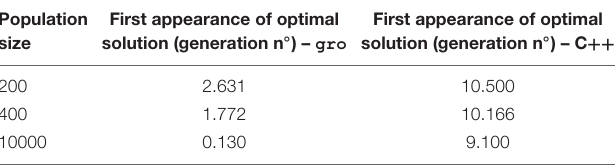
TABLE 5 | Initial population size variation for